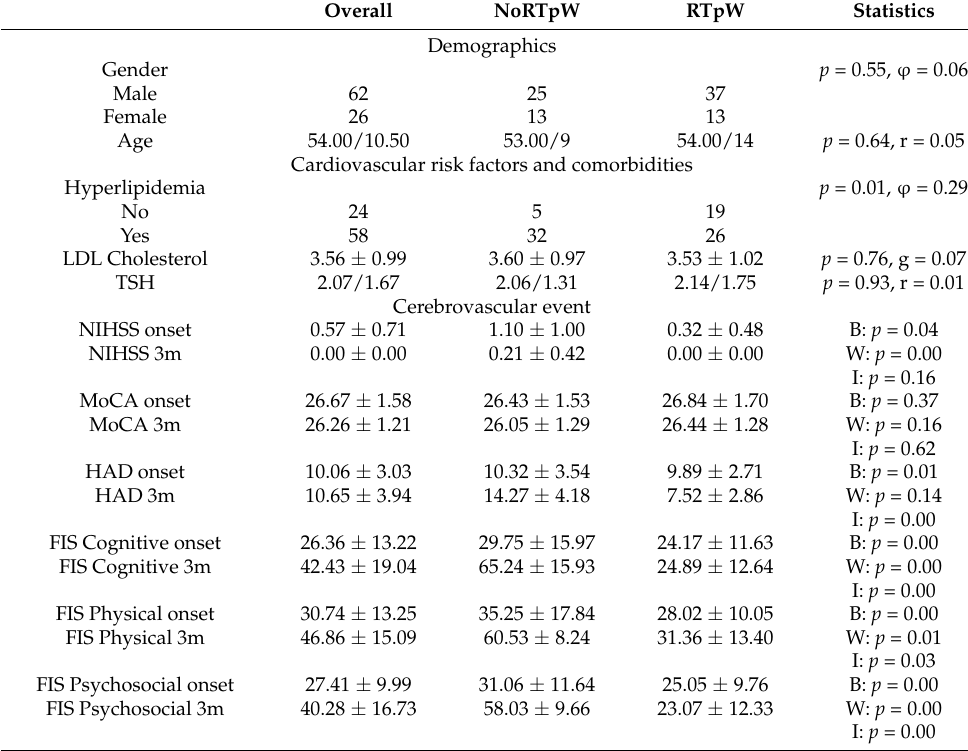
Figure 1. Study flow diagram. MIS = Minor ischemic stroke; NoRTpW = No Return to Paid Work; RTpW = Return to Paid Work; TIA = Transient ischemic attack. Table 1. Demographics and clinical characteristics of the study population according to returning to paid work at three